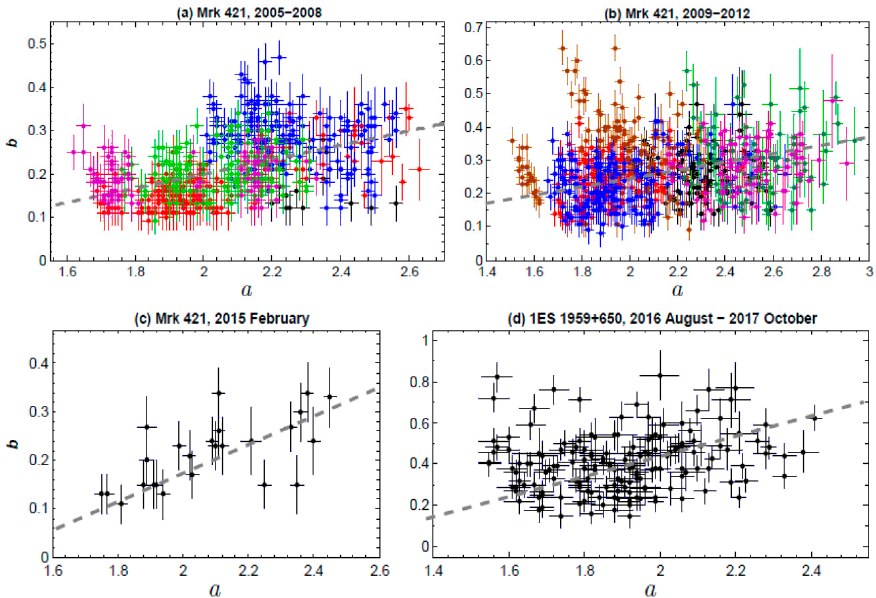
Figure 2. The a-b correlation for Mrk 421 ( a – c ) and 1ES 1959+650 ( d ) observed with Swift-XRT in different periods (reproduced from References [24,25,27,28]). In ( a , b ), the colored points correspond to the different intervals of the periods 2005–2008 and 2009–2012 (see References [24,25] for details). Gray dashed lines represent linear fits to scatter